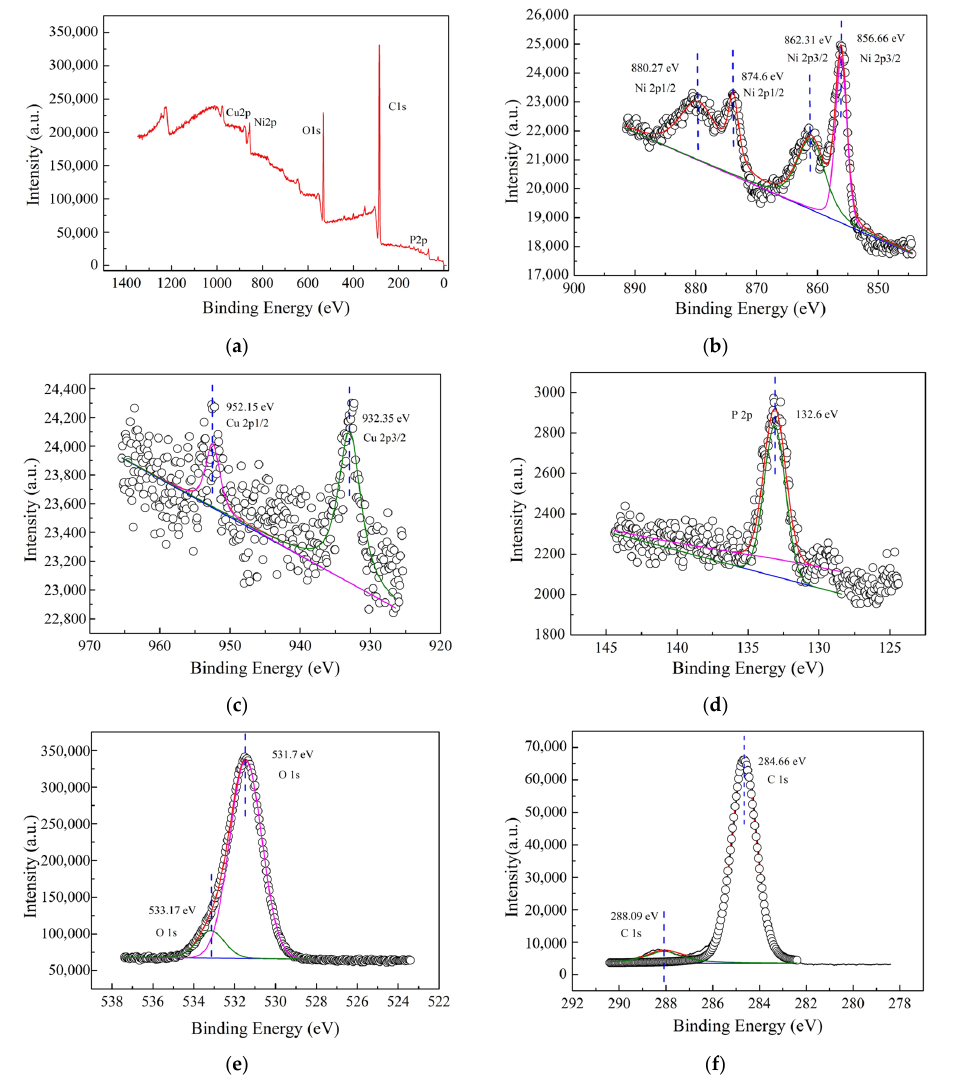
Figure 5. XPS spectra. ( a ) Survey spectrum; ( b ) Ni 2p; ( c ) Cu 2p; ( d ) P 2p, ( e ) O 1s, ( f ) C 1s.